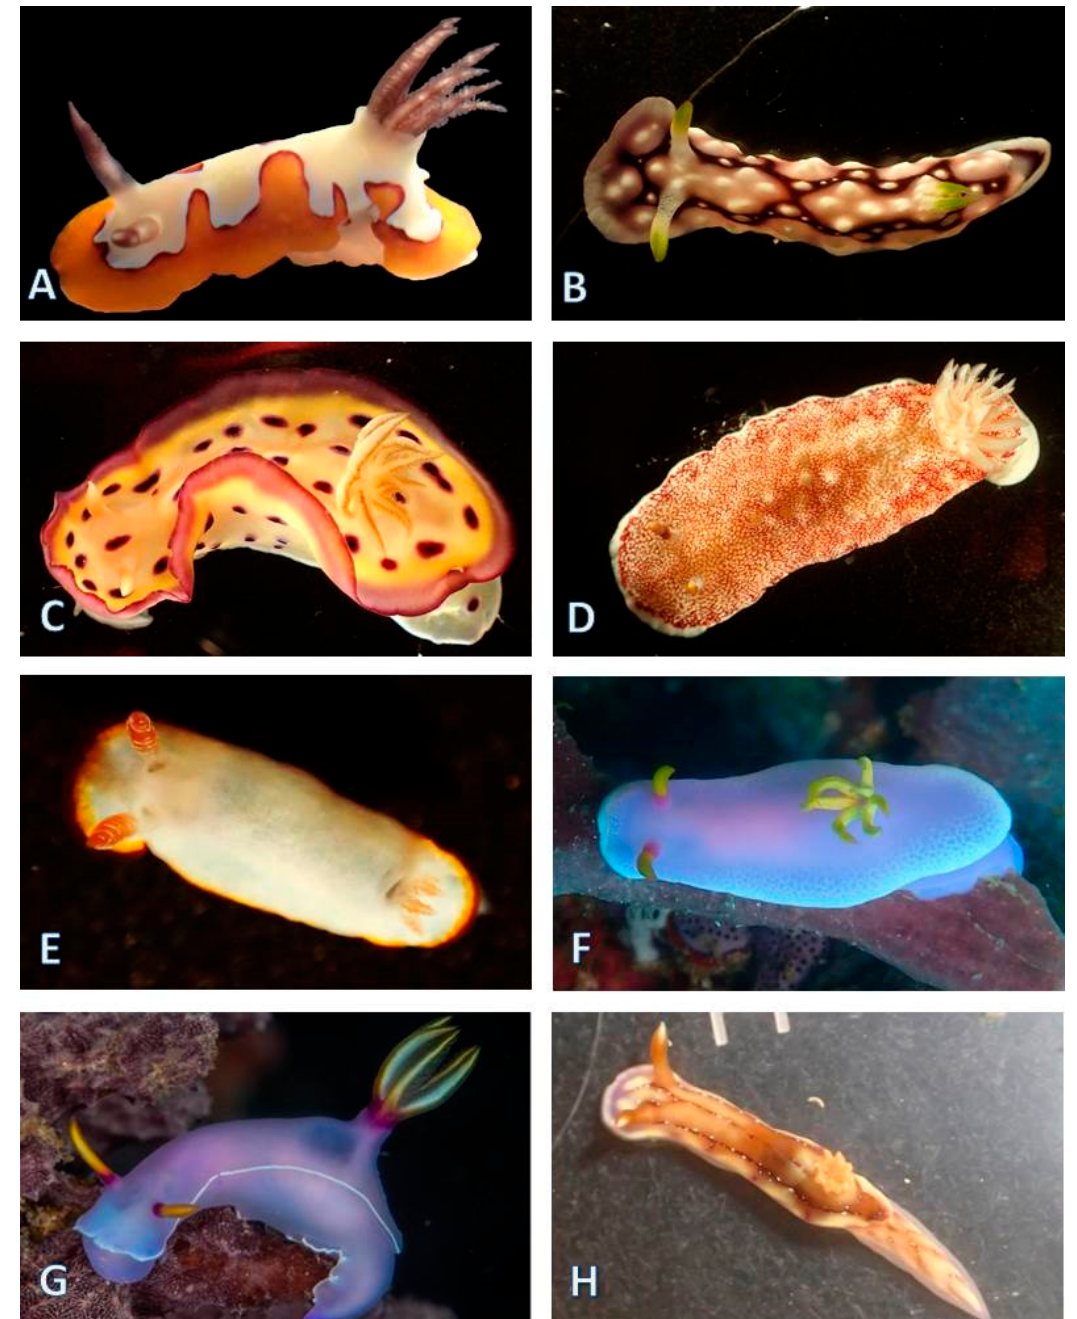
Figure 13. Nudibranchia Doridina: ( A ) Goniobranchus fidelis , Gofi17Ba-1; ( B ) Goniobranchus geometricus , Goge18Ba-5; ( C ) Goniobranchus kuniei , Goku18Ba-1; ( D ) Goniobranchus reticulatus , Gore18Ba-1; ( E ) Goniobranchus verrieri , Thho18Ba-1; ( F ) Hypselodoris apolegma , Hyap17Ba-1; ( G ) Hypselodoris bullockii *; ( H ) Hypselodoris cerisae , Hysp1.17Ba-1. *Specimen not collected.